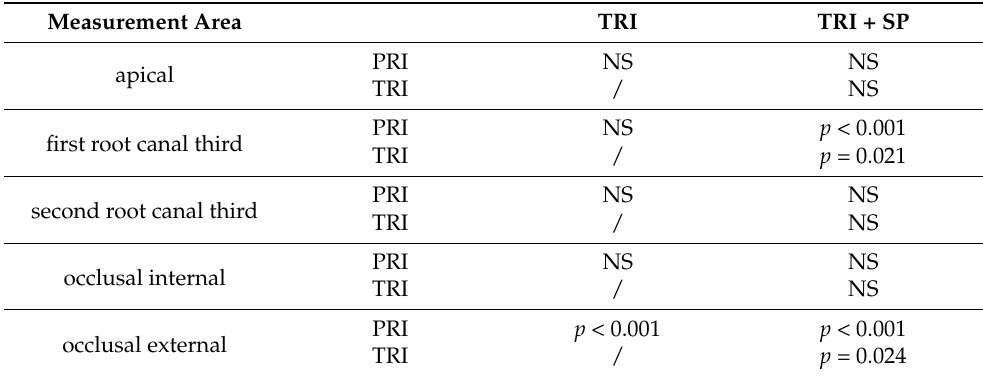
Table 2. p -values of pairwise comparison ( p -value < 0.05, NS = not significant) for the linear discrep- ancies between intraoral scans of the three impression methods (PRI = Primescan, TRI = Trios 4, and TRI+SP = Trios 4 and scanpost) and µ -CT reference distributed to the five measurement areas. Measurement Area